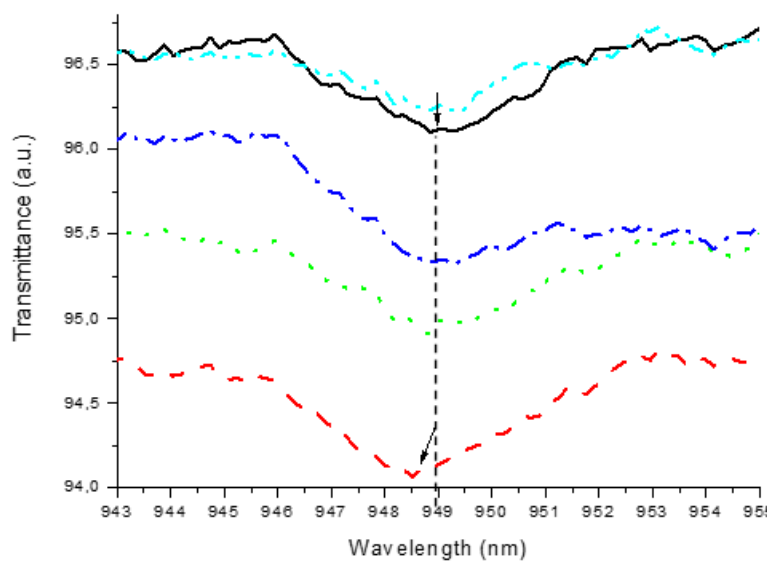
Figure 6. Localized Surface Plasmonic Resonance (LSPR) measurement: resonance and peak shift under laser pointer illumination; black line: initial curve; red curve: under illumination; green, blue: after switch-off; light blue: final configuration. λ = 405 nm; power ~25 mW; spot area = 1 cm 2 .